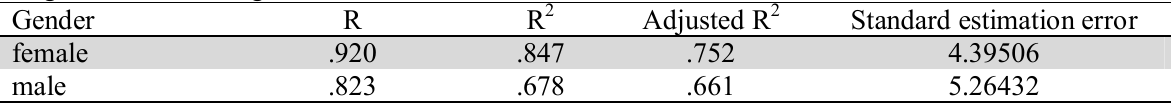
Regression based on gender Gender R R 2 Adjusted R 2 Standard estimation error female male Analyzing standard deviation of regression based on gender gender Total square roots df Mean squares Test F Sig. Regression 857.182 Female Regression